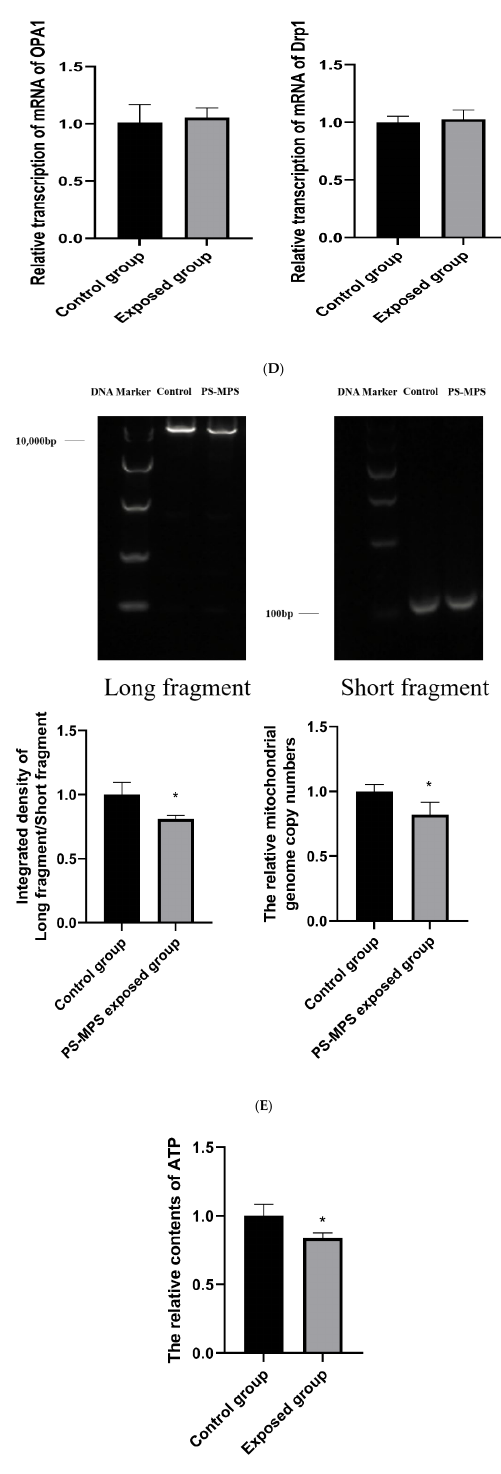
Figure 3. Mitochondrial structural and functional damage after exposure. ( A ) Expression of mitophagy protein; ( B ) Expression and transcription of mitophagy regulatory proteins; ( C ) mitochondrial membrane potential; ( D ) Expression and transcription of mitochondrial fission and fusion proteins; ( E ) Mitochondrial genetic characteristics; ( F ) ATP contents. The data are expressed as the mean ± SD (n = 8) and analyzed by dependent sample t -test. Note: * p < 0.05, indicates a statistically significant difference from the control.